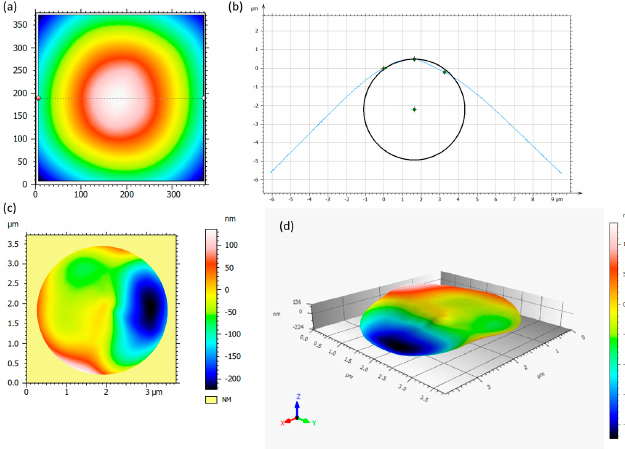
Figure 31. ( a ) Depicts the location of the extracted tip profile, which was obtained through the very tip of the probe’s apex. ( b ) Illustrates a circle with a nominal radius of 2.71 μ m fit to the profile presented and obtained in ( a ). The circle in ( b ) is positioned such that it is both coincident with the tip of the apex as well as parallel to the z -axis. Notice the deviation from the imposed circle in ( b ) by the profile between approximately 1.5 and 3.5 μ m on the horizontal axis. ( c , d ) Present the deviation of the true surface from an ideal sphere of a 2.71 μ m radius. The rendering’s shown in ( c ) and ( d ) are normalized in the x- and y-directions with vertical distortion in the z-direction to clearly capture the deviation via colored contour plotting.